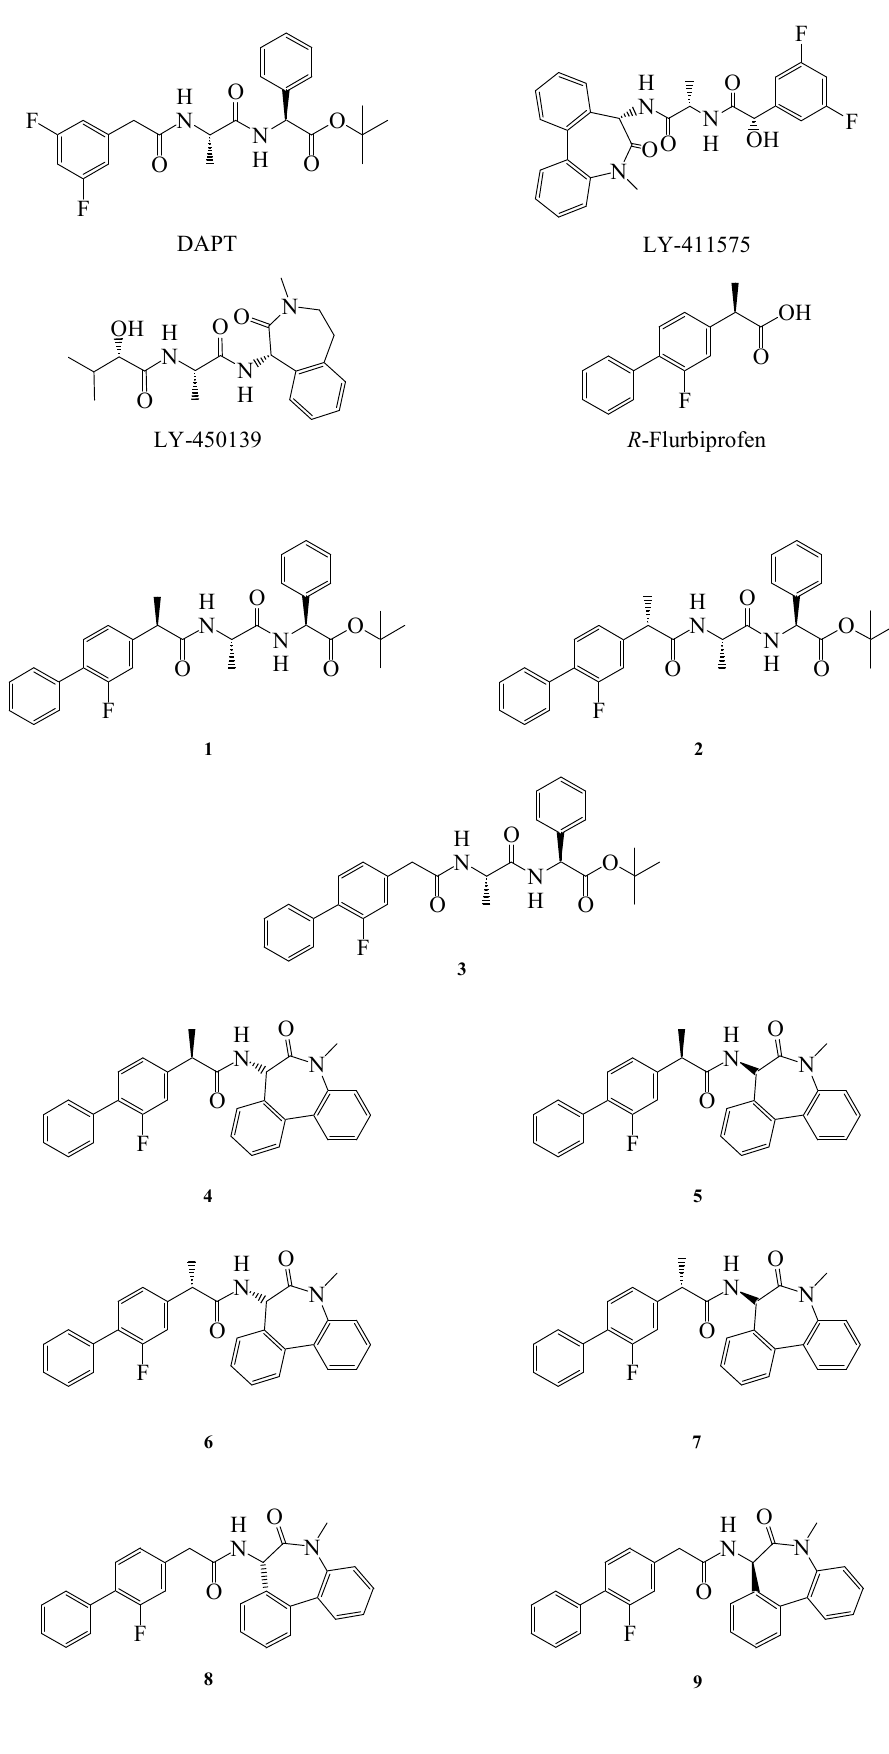
Figure 1. Structure of GSIs, GSMs and compounds 1 – 9